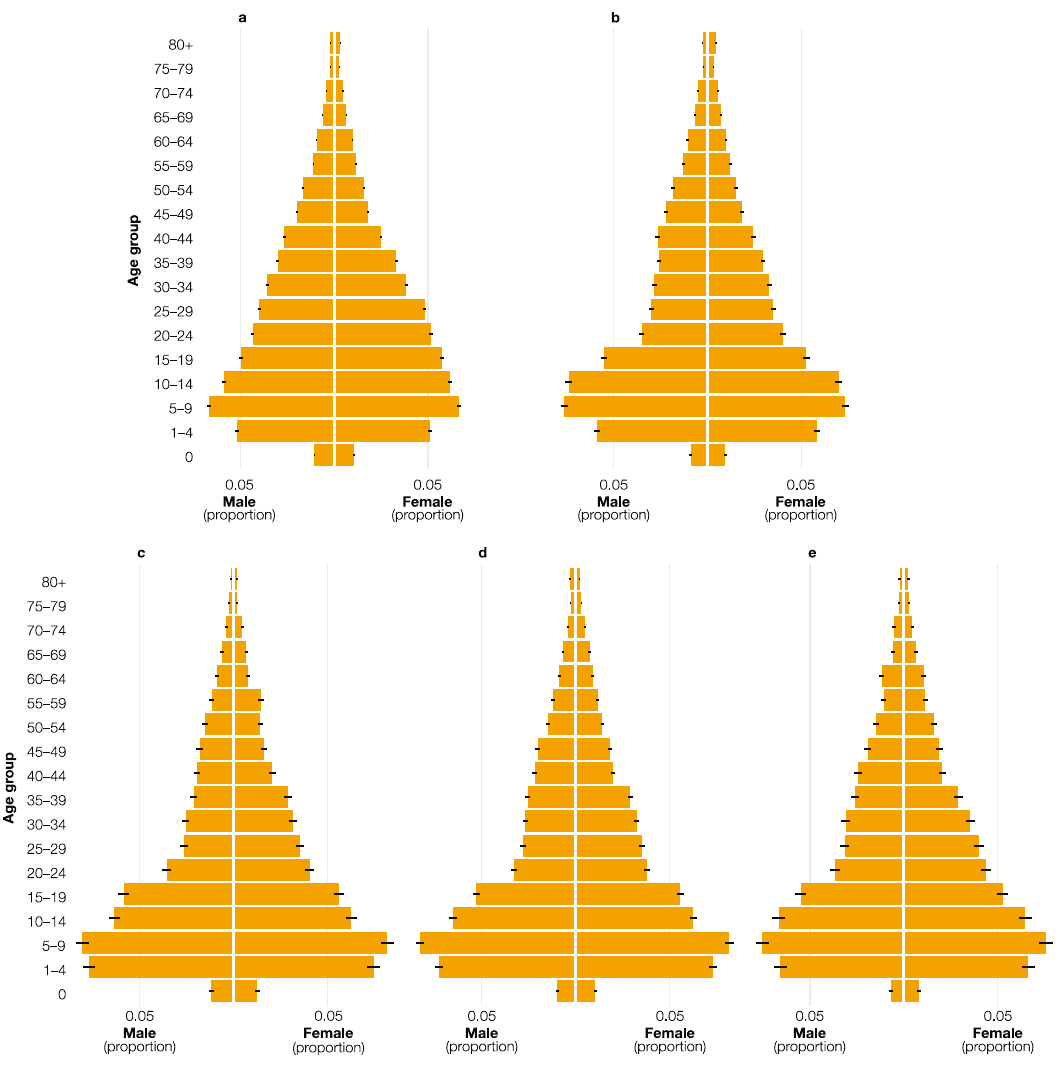
Fig. 5 Predicted age and sex structures. Population pyramids presenting the means of the posterior distribution ( n = 10,000) for each age and sex proportion for the provinces of ( a ) Kinshasa, ( b ) Kongo Central, ( c ) Kwango, ( d ) Kwilu, and ( e ) Mai-Ndombe. The horizontal black lines show the 95% credible intervals derived from the respective posterior distribution ( n = 10,000). Source data are provided with this paper.